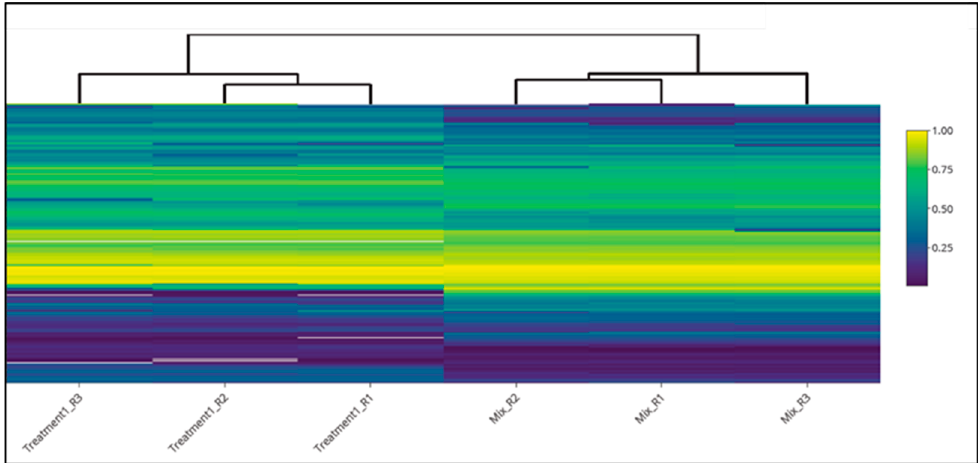
Figure 5. Heat map generated by MStractor. Figure 5.